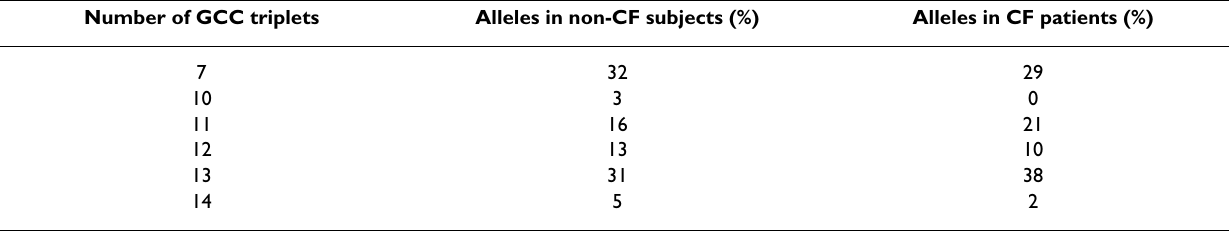
Table 1: MRP1 (GCC)n alleles frequencies in non-CF and CF subjects Number of GCC triplets Alleles in non-CF subjects